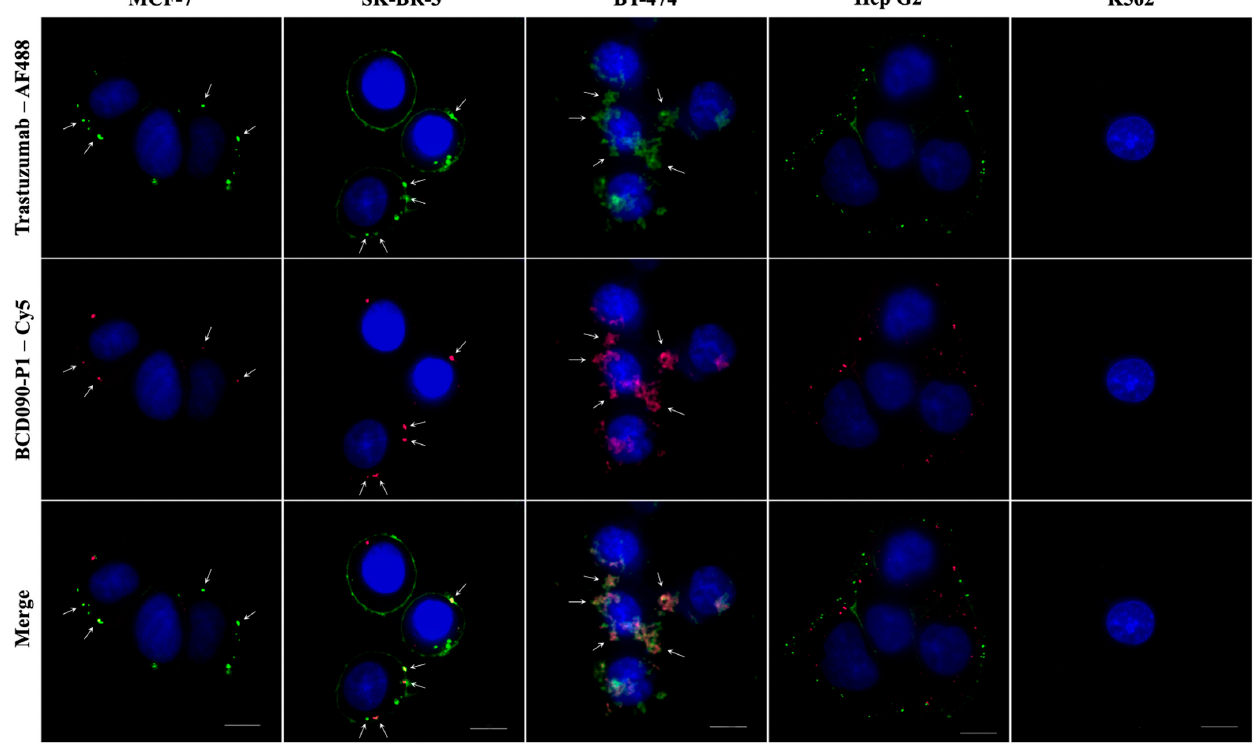
Figure 7. Immunofluorescent staining of cancer cells with anti-ErbB2 and anti-ErbB3 antibodies. Images obtained with trastuzumab or BCD090-P1 show similar staining patterns with most receptors localized in individual clusters presumably located on the plasma membrane and partly within intracellular vesicles. Non-epithelial K562 cells devoid of ErbB receptors were used as a negative control and did not show considerable staining with either antibody. The ErbB2 and ErbB3 receptors show remarkable co-localization in the breast adenocarcinoma cell lines MCF-7, SK-BR-3 and BT-474, but not in hepatocellular carcinoma Hep G2. White arrows indicate the ErbB2 and ErbB3 co-localization spots. Scale bars 10 µ